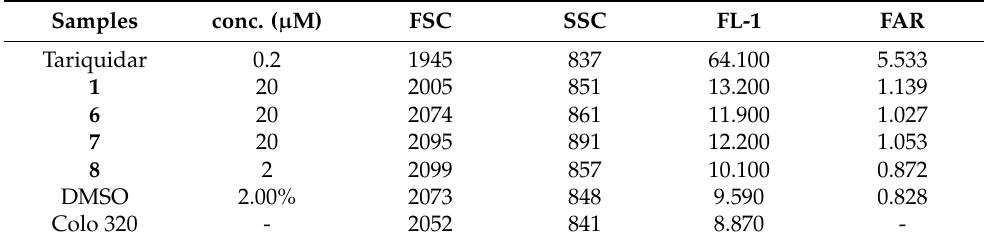
Table 5. Effect of compounds 1 , 6 – 8 on the P-glycoprotein (P-gp)-mediated rhodamine-123 efflux on MDR human colon adenocarcinoma (Colo 320).